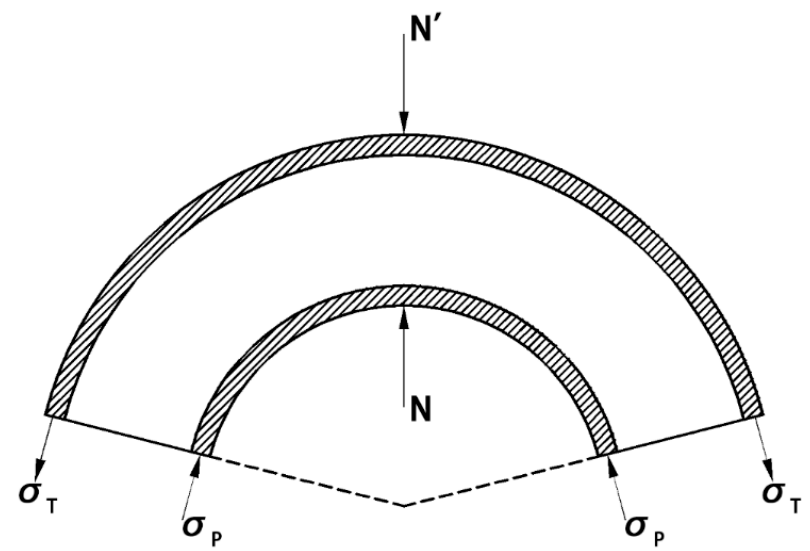
Figure 2. Stress state during cold